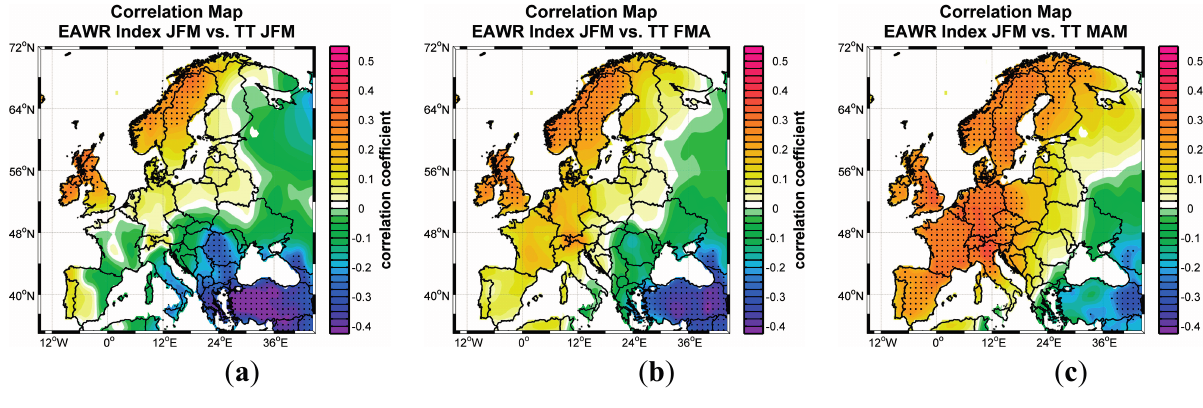
Figure 4. Correlation between the JFM EAWR and CRU T.S. 3.2 Temperature (TT) for ( a ) January to March (JFM); ( b ) February to April (FMA) and ( c ) March to May